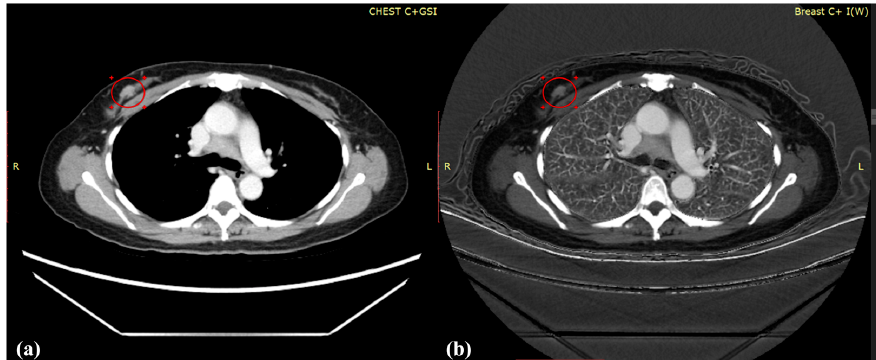
Figure 3. ( a ) Monochromatic spectral image and ( b ) iodine map for a 45-year-old patient with breast cancer and breast density of 54%; the average T/B, T/M, and CNR b were ( a ) 2.68, 1.15, and 7.65, respectively, and ( b ) 7.88, 1.59, and 14.81, respectively.